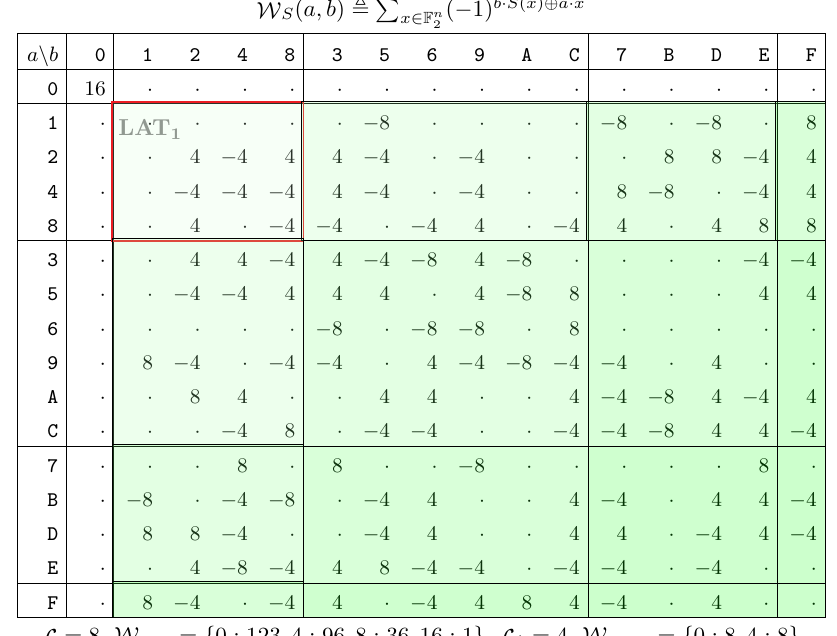
Figure 3: The LAT/LAT 1 of the Serpent S-boxes S 0